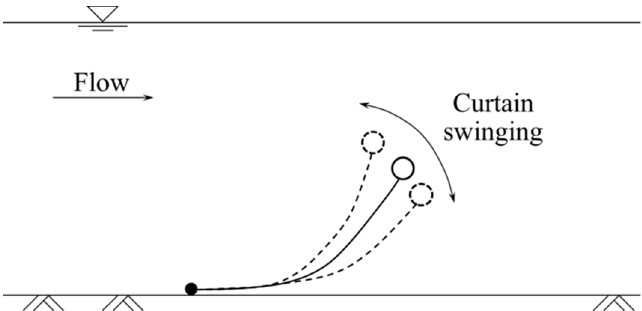
Figure 6. Up and down-swaying deflector in flow.